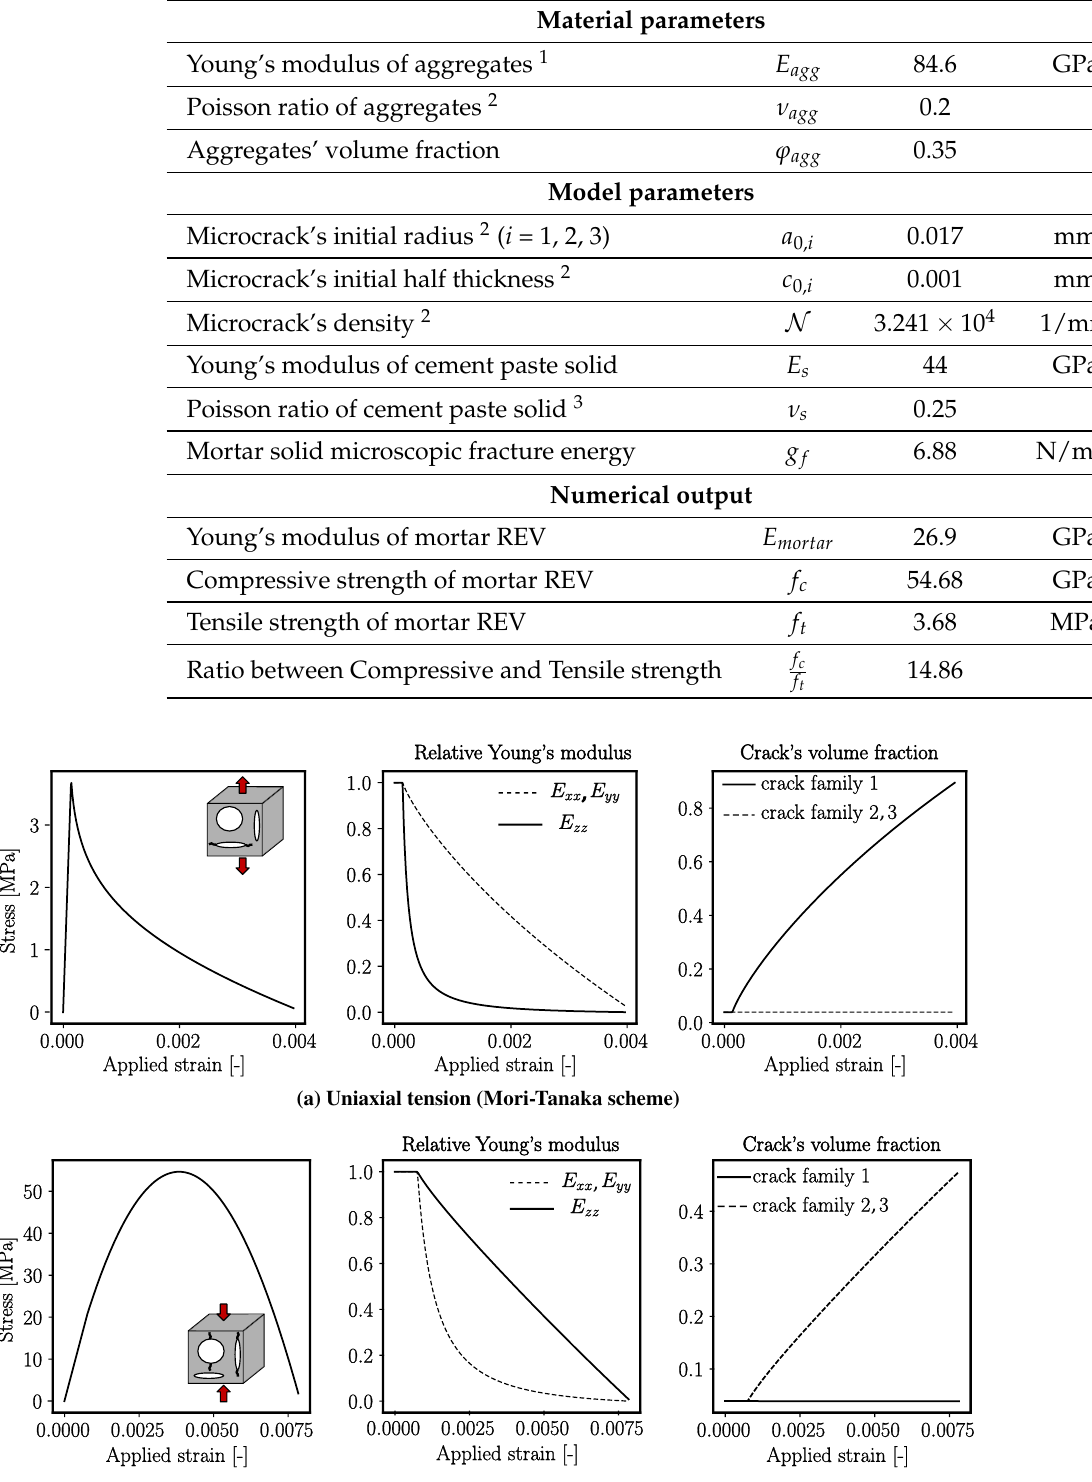
Table 4. Summary of parameters used for the analysis of a mortar REV subjected to uniaxial loading.